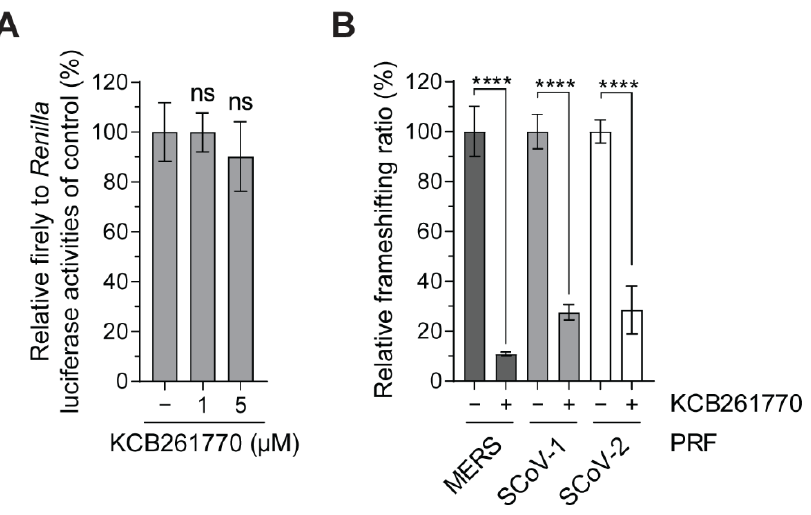
Figure 5. Comparison of the inhibitory effects of compound KCB261770 on − 1 PRFs of SARS-CoV, SARS-CoV-2, and MERS-CoV. ( A – B ) Frameshifting ratio relative to the untreated control was measured with or without compound KCB261770 (5 µM) in the indicated − 1 PRFs. Frameshifting ratio was measured in the control cells, which does not have a PRF signal ( A ) or in the cells harboring coronavirus − 1 PRFs ( B ). Frameshifting ratio of the each indicated PRF without treatment was set to 100%. MERS; MERS-CoV PRF, SARS-1; SARS-CoV PRF, SARS-2; SARS-CoV-2 PRF. **** p < 0.001, ns; not significant vs. control (one-way ANOVA with Tukey’s multiple comparisons test).